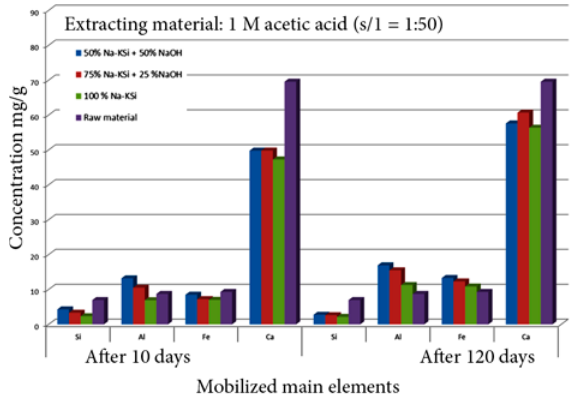
Fig. 9. Quantity of mobilized main elements from geopolymers (at 10 and 120 days age) using different alkaline activator solutions in 1 M acetic acid (solid/liquid ratio 1:50)